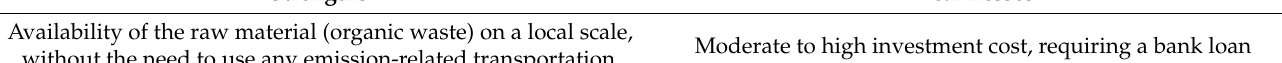
Table 6. The SWOT analysis of biogas implementation, prepared on the basis of this work and results presented elsewhere [44–47].